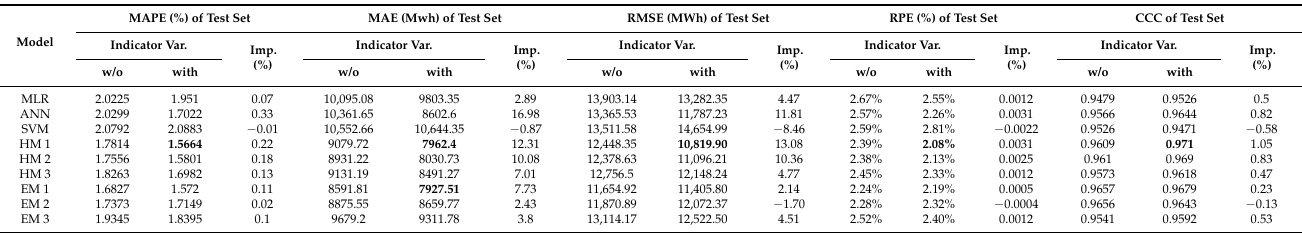
Table 13. Impact of adding indicator variables on various forecast